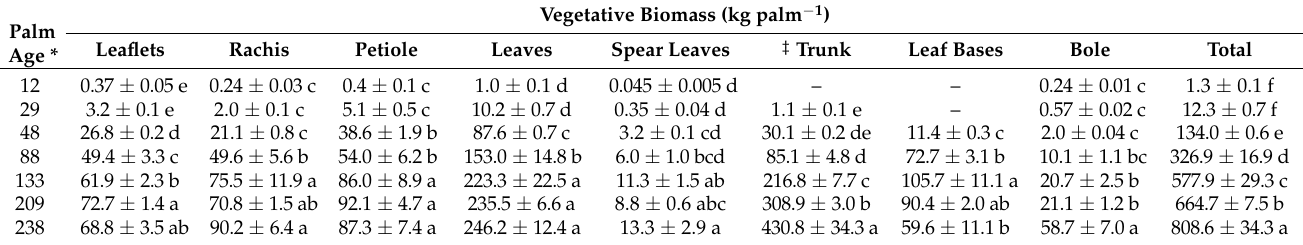
Table 2. Dry weights (mean ± SE) of standing vegetative biomass of tenera oil palm sampled in Malaysia. Palm Age